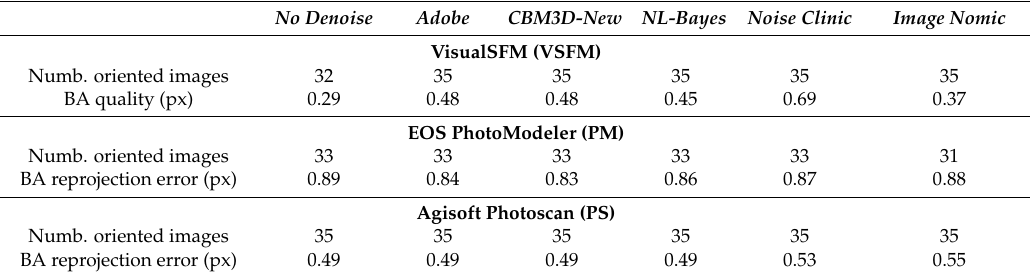
Table 3. Bundle adjustment (BA) results for every denoising procedure on Dataset 2. Adobe method is Camera Raw 6 with Process 2010 (see Section 3.1). On such a small dataset, Photoscan seems to be quite robust even without any pre-processing method. No Denoise Adobe